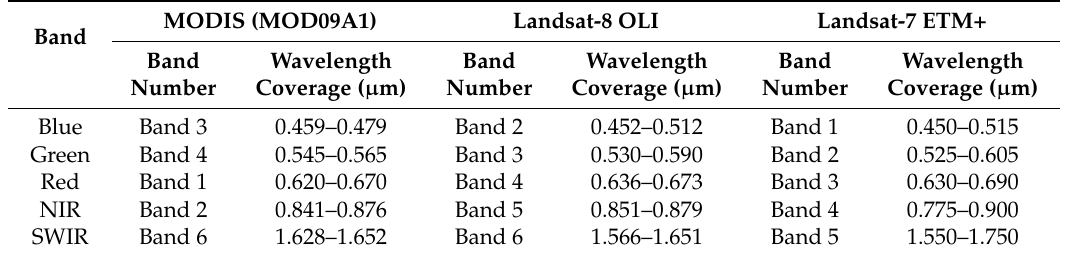
Table 2. Band information of MODIS, Landsat-8 OLI, and Landsat-7 ETM+.